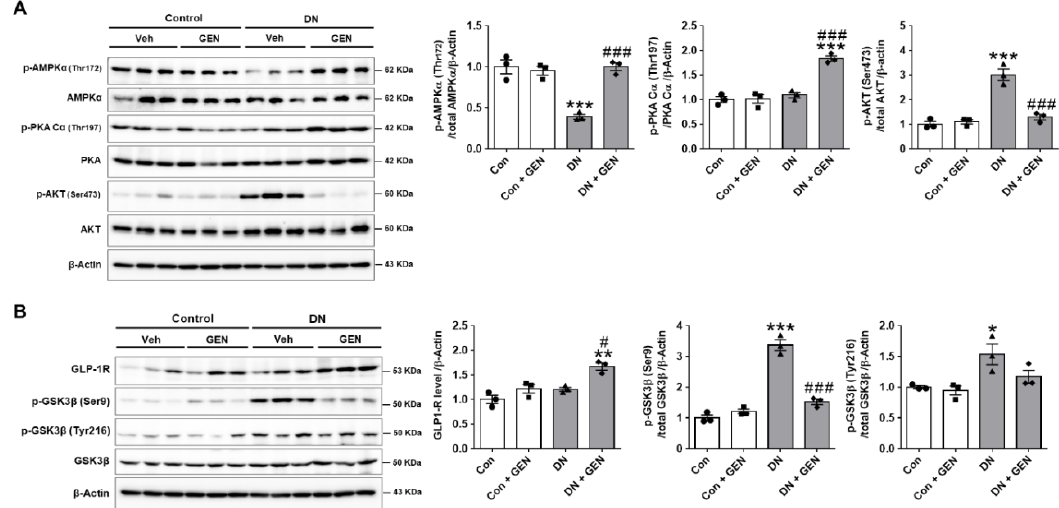
Figure 6. Geniposide protects the kidney through AMPK activation and AKT inhibition in DN. ( A ) The protein expression levels of p-AMPKα (Thr172), p-PKA Cα (Thr197), p-AKT (Ser473), and β-actin, as a loading control, were determined by western blot analysis in kidney tissue lysates. Quantitative analysis of each protein level was shown ( n = 3). ( B ) The protein expression levels of GLP-1R, p-GSK3β (Ser9), p-GSK3β (Tyr216), GSK3β and β-actin, as a loading control, were determined by western blot analysis in kidney tissue lysates. Quantitative analysis was shown ( n = 3). Data are presented as the mean ± SEM. One-way ANOVA was used for statistical analysis followed by Bonferroni’s multiple comparisons. * p < 0.05, ** p < 0.01, *** p < 0.001 vs. control mice; and # p < 0.05, ### p < 0.001 vs. DN mice.